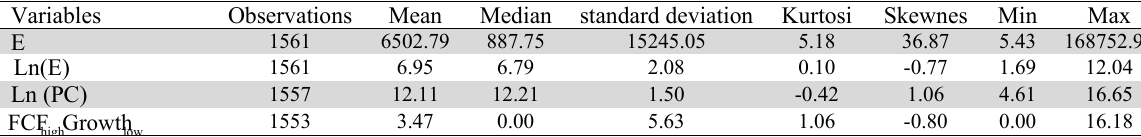
Descriptive Statistics for different variables Variables